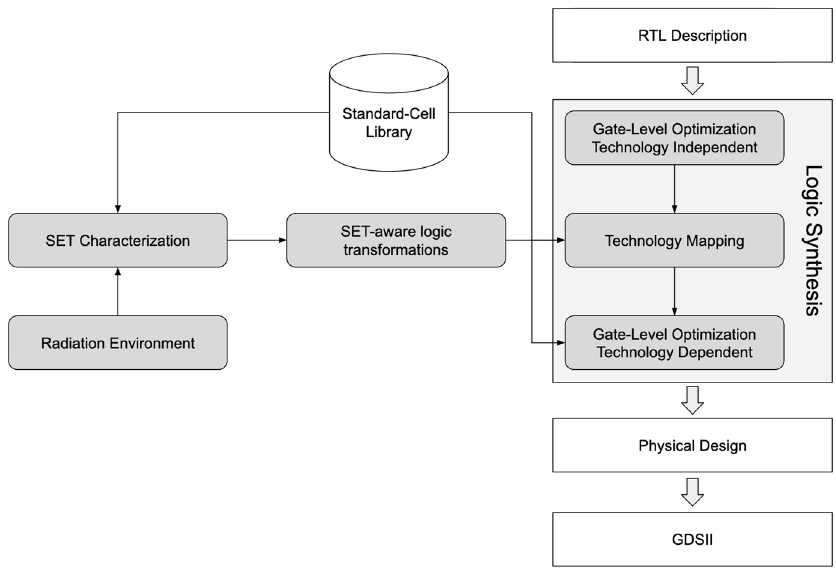
Figure 3. Integration of SET characterization of standard-cell library into the logic synthesis.